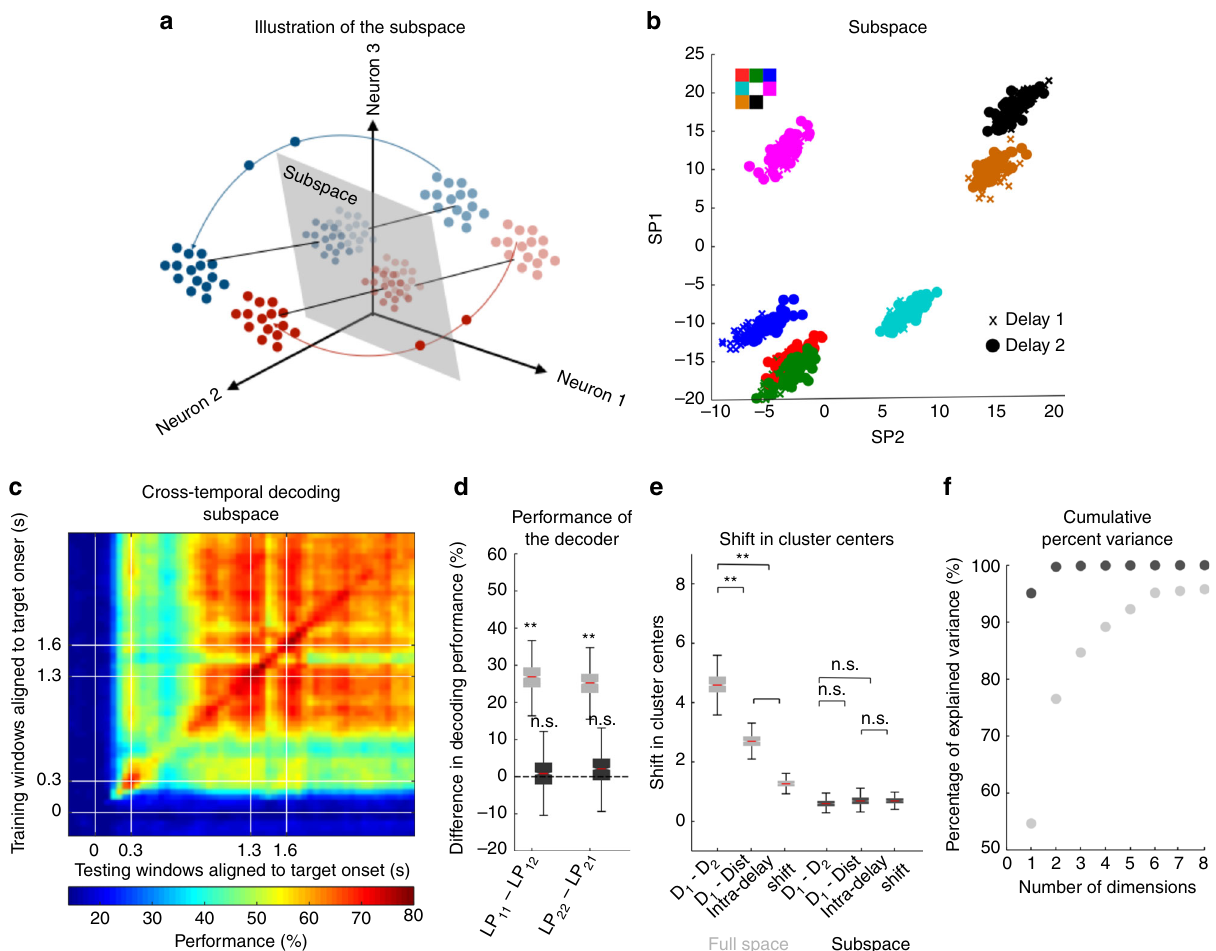
Fig. 2 Identi fi cation of a subspace. a Illustration of the subspace where Delay 1 and Delay 2 activity exists as one persistent code. b Delay 1 (plotted using crosses) and Delay 2 (plotted using squares) responses after projection into the top 2 dimensions of the subspace. Points for different target locations are color-coded according to the color scheme shown in the top left. c Heat map showing the cross-temporal population-decoding performance after the population responses were projected onto the subspace. White lines indicate target presentation (0 – 0.3 s) and distractor presentation (1.3 – 1.6 s). d The difference in decoding performance when a decoder that was trained on Delay 1 responses was tested on Delay 1 ( LP 11 ) or Delay 2 ( LP 12 ) responses are shown in the gray box-plot labelled LP 11 – LP 12 , and vice versa (gray box-plot labelled LP 22 – LP 21 ). The equivalent performance differences in the subspace are shown in the black box-plots. e The shift in cluster centers from Delay 1 to Delay 2 (labeled D 1 – D 2 ) averaged across target locations, from Delay 1 to the distractor presentation period (D 1 - Dist), and the intra-delay shifts in both Delays 1 and 2 (intra-delay) are shown in the full space (gray box-plot), and in the subspace (black box-plot). f The cumulative explained variance is plotted as a function of the number of PCs for the full space (plotted in gray) and the subspace (plotted in black). The explained variance denoted the dimensionality of the projections in the full space and the subspace (not to be confused with the 58 dimensions that explained 90% of the variance in normalized z-scored data). This was performed to show that the dimensionality of the subspace was lower than that of the full space. The bounds in the boxplots are de fi ned by the 25th and 75th percentile of the distribution. The red line represents the median and the whiskers represent the 2.5th and 97.5th percentile of the